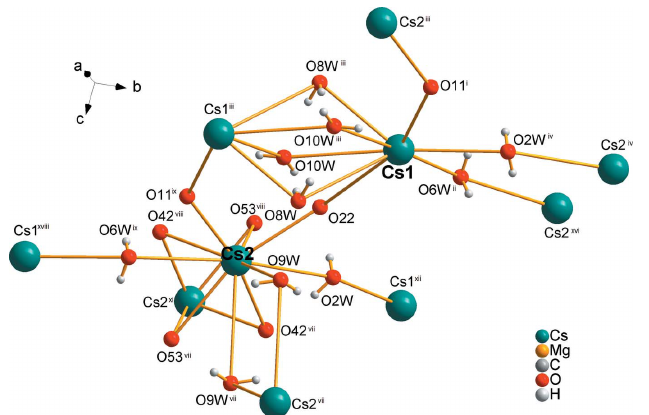
Figure 7 Figure 8 Linkage of Cs cations by O atoms, with all atoms drawn as spheres of Interconnection of double chains (at the corners), the arbitrary radii (other atoms are left out for clarity). [Symmetry codes: (i) [Mg2(H 2 O) 3 (CO 3 ) 2 ] 2– units (in the middle) and the free water molecule x (cid:4) 1, y , z ; (ii) x (cid:4) 1 , (cid:4) y + 3 , z + 1 ; (iii) (cid:4) x + 2, (cid:4) y + 1, (cid:4) z ; (iv) x (cid:4) 1 , (cid:4) y + 3 , 2 2 2 2 2 via hydrogen bonds in the crystal structure of Cs 2 Mg 4 (CO 3 ) 5 (cid:2) 10H 2 O. z (cid:4) 1 ; (vii) (cid:4) x + 2, (cid:4) y + 1, (cid:4) z + 1; (viii) x + 1, y , z ; (ix) (cid:4) x + 3, (cid:4) y + 1, (cid:4) z ; 2 Hydrogen bonds are represented by dashed lines; Cs atoms are omitted (xi) (cid:4) x + 3, (cid:4) y + 1, (cid:4) z + 1; (xvi) (cid:4) x + 5 , y + 1 , (cid:4) z + 1 ; (xviii) (cid:4) x + 5 , y (cid:4) 1 , 2 2 2 2 2 (cid:4) z + 1 for clarity. 2